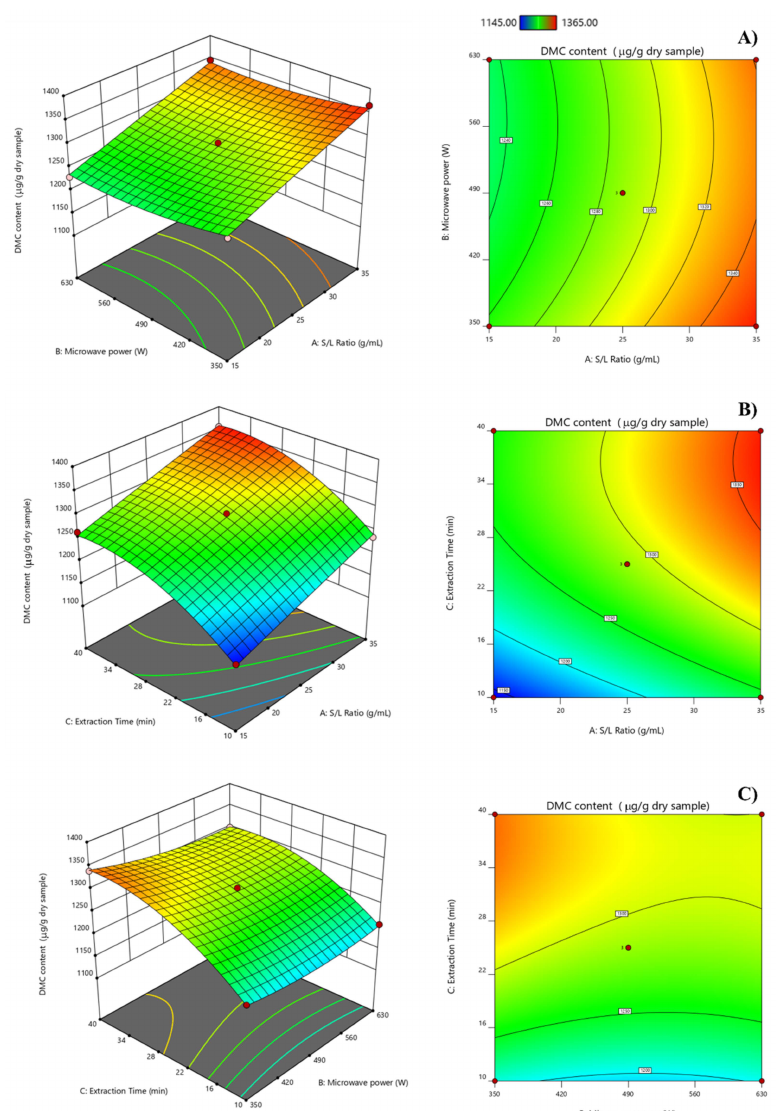
Figure 4. Response surface (3D) and contour (2D) plots describe the interactive impacts of MAE parameters; ( A ) solid-to-liquid ratio (X 1 ) and microwave power (X 2 ); ( B ) solid-to-liquid ratio (X 1 ) and microwave time (X 3 ); and ( C ) microwave power (X 2 ) and microwave time (X 3